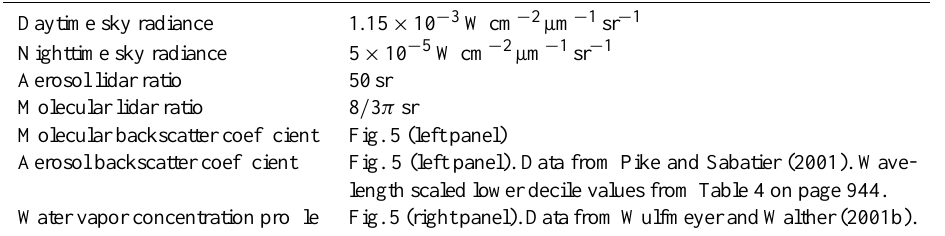
Table 2. Model atmosphere parameters used to calculate the performance. Daytime sky radiance